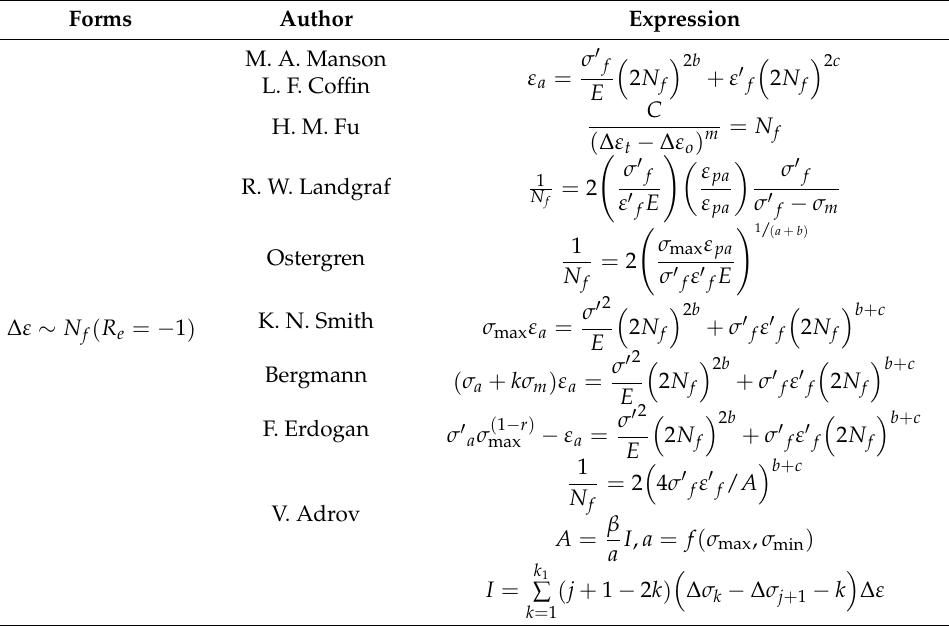
Table 5. Strain fatigue curve.